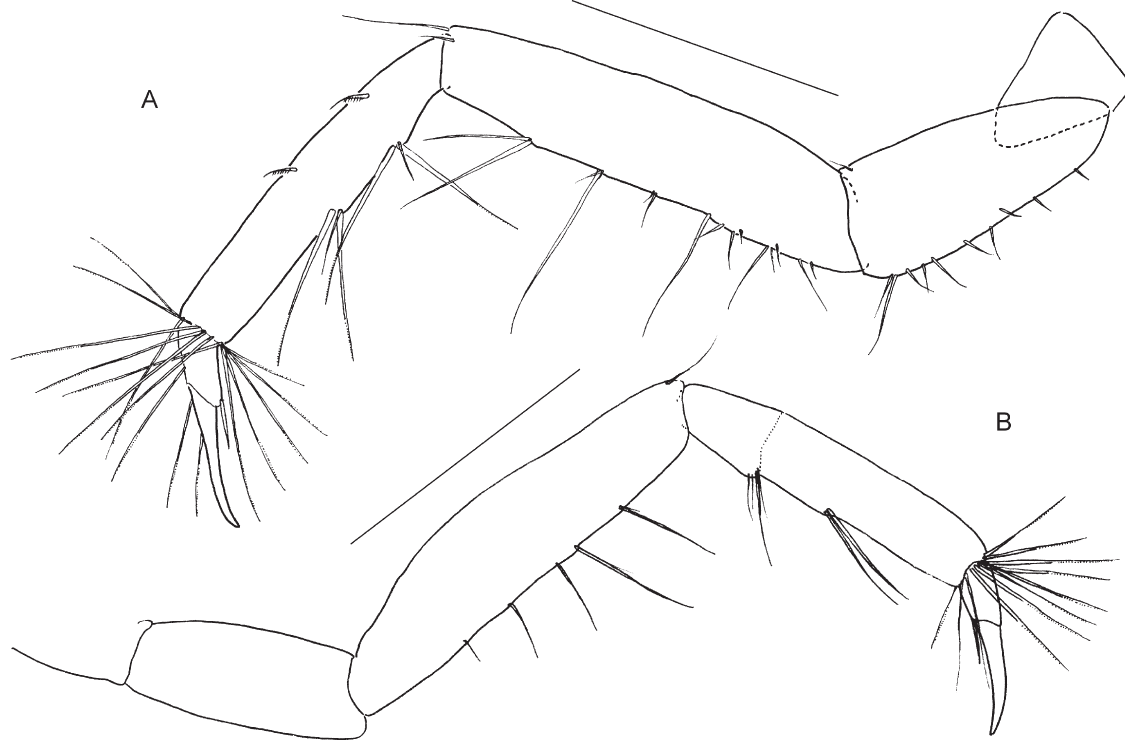
Fig. 6. Siriella bassi sp. nov., holotype, ♀ , length 8.5 mm, Australia, Victoria, Western Bass Strait. A . Endopod of pereopod 1, posterior view. B . Endopod of pereopod 2, posterior view. Scale bars: 0.25